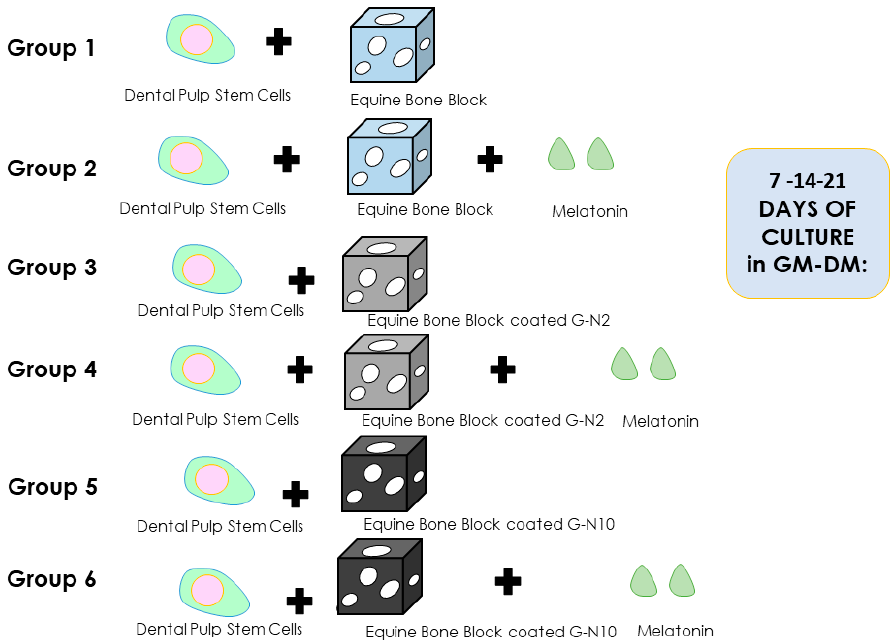
Figure 1. Design of the study.